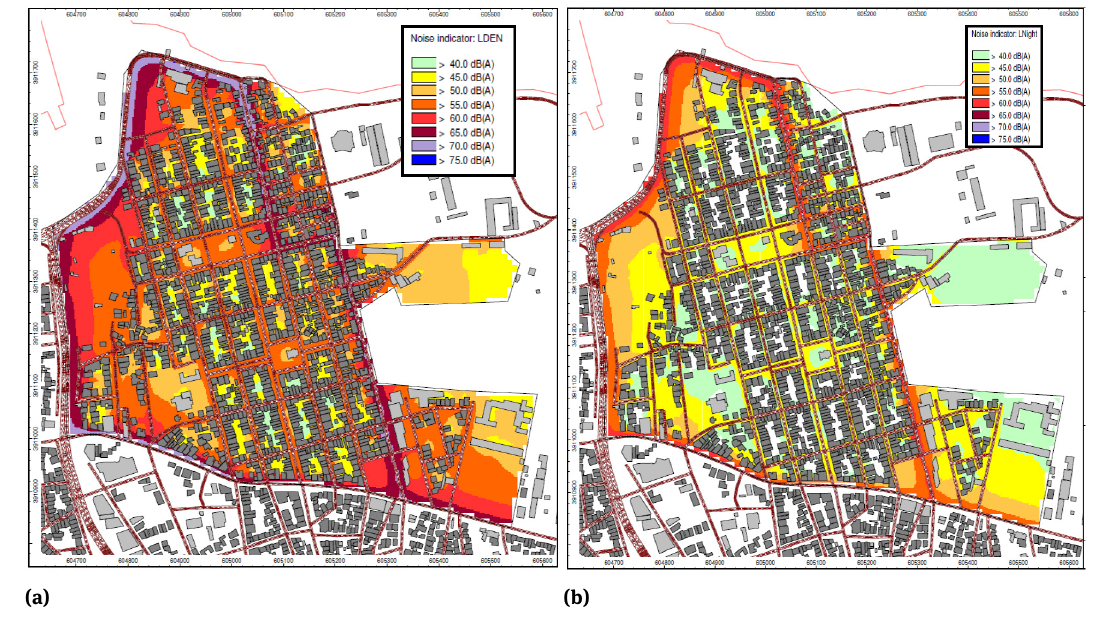
Fig. 17. Noise Action Maps L den (a) and L night (b) for the Alikarnassos study area after the Int. airport relocation to Kastelli.